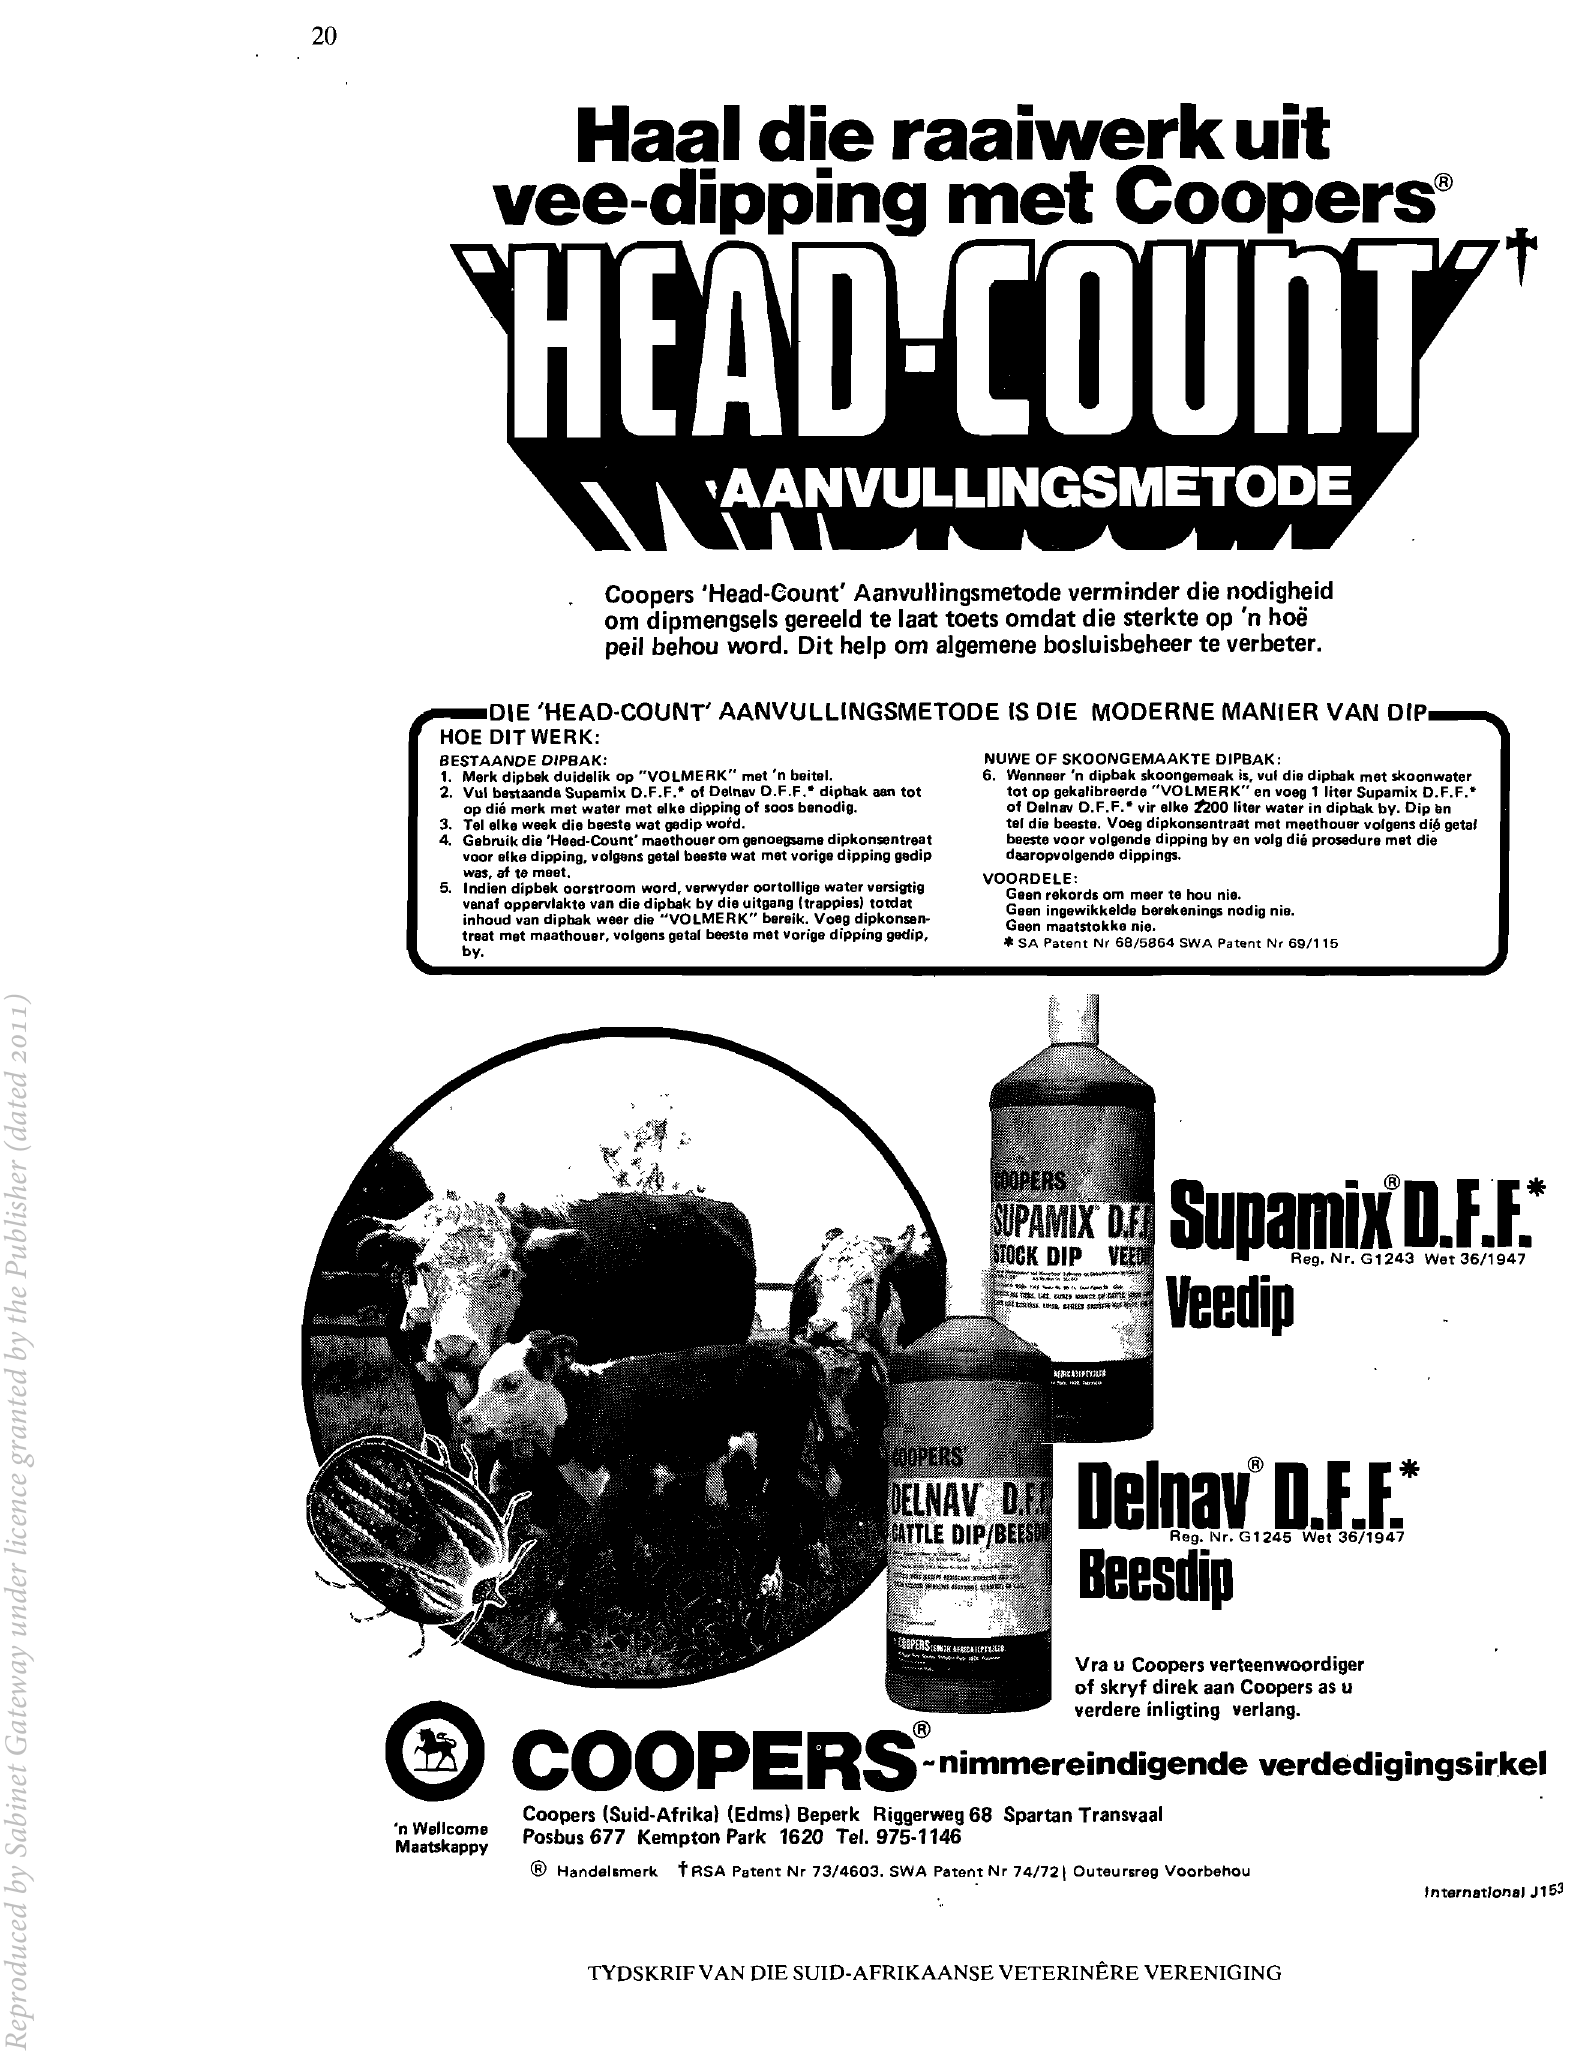
COOPERS~nimmereindigende Coopers (Suid-Afrikal (Edmsl Beperk Riggerweg 68 Spartan Transvaal Posbus 677 Kempton Park 1620 Tel.